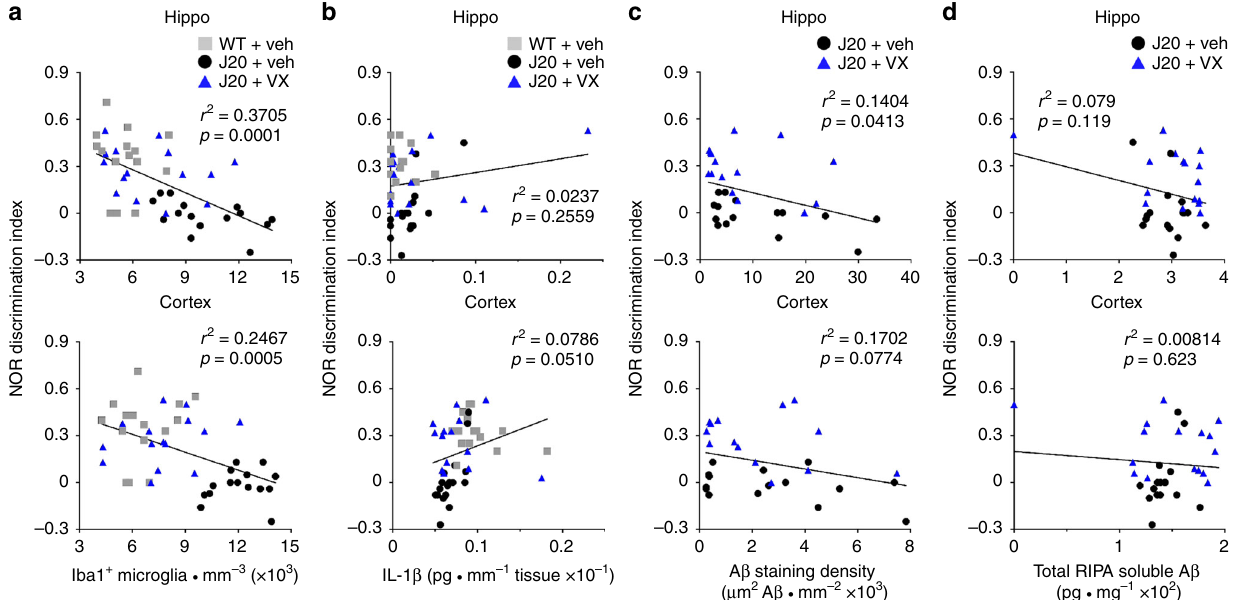
Fig. 7 Microglial activation, not A β , leads to cognitive de fi cits in J20 mice. a – d Scatter plot and linear regression analyses of all behaviourally-tested WT and J20 mice comparing NOR discrimination index to a Iba1-positive microglial numbers (hippo r 2 = 0.3705, cortex r 2 = 0.2467), b ELISA-measured IL-1 β (hippo r 2 = 0.0237, cortex r 2 = 0.0786), c A β staining density (hippo r 2 = 0.1404, cortex r 2 = 0.1702) and d RIPA-soluble total A β (hippo r 2 = 0.079, cortex r 2 = 0.00814). In ( a ), n = 15 mice per group, ( b ) n = 17 WT + Veh, 16 J20 + Veh and 16 J20 + VX mice, ( c ) n = 15 J20 + Veh and 15 J20 + VX mice, ( d ) n = 16 mice per